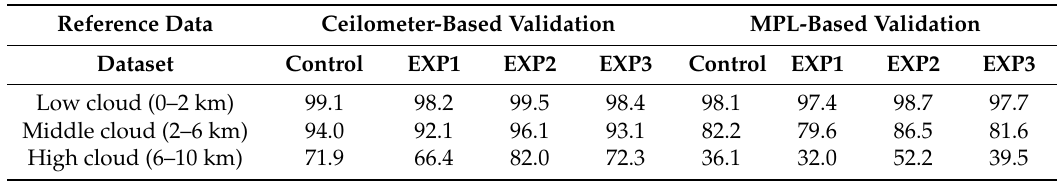
Table 8. The POD scores of the four experimental datasets for the different cloud base heights. The low, middle, and high clouds correspond to the layers of 0–2 km, 2–6 km, and over 6 km, respectively. Here, the range of high clouds is limited to below 10 km, considering the occurrence frequency of the higher clouds, while the altitude range of low clouds is different (0.5–2 km) in the MPL-based